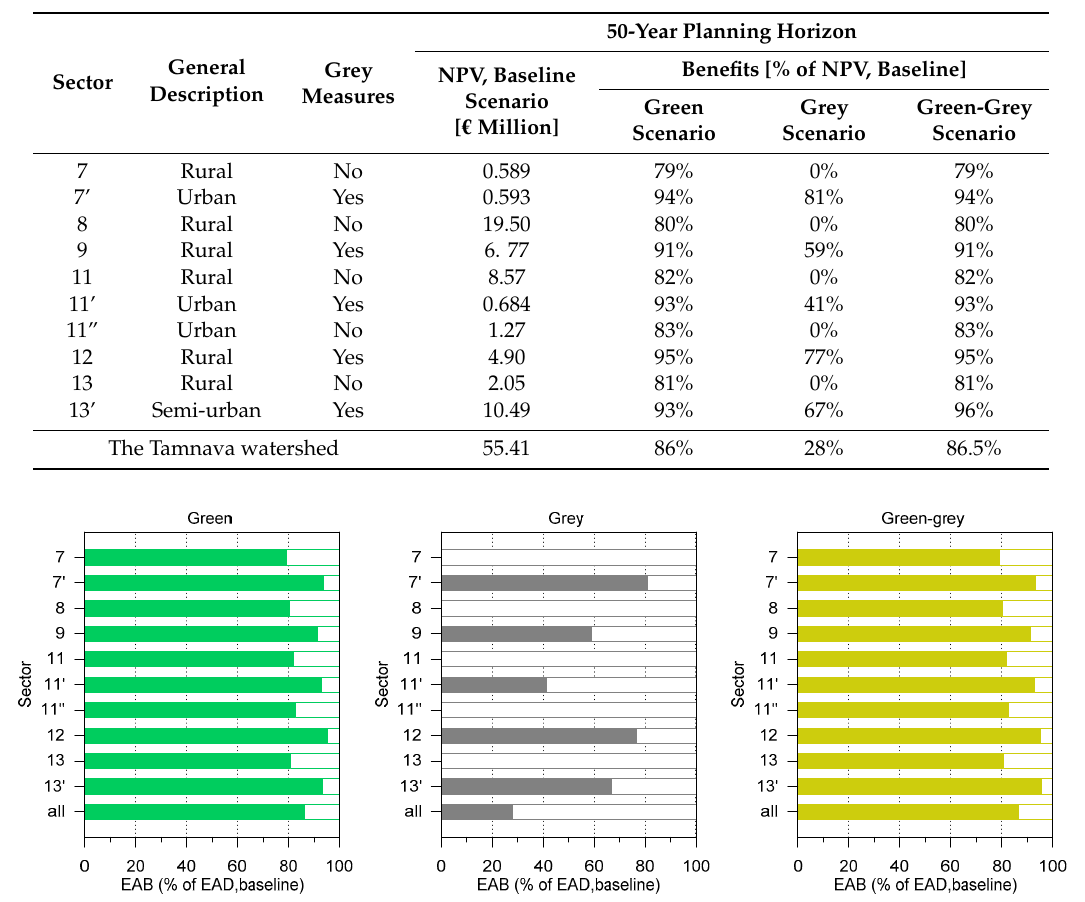
Table 8. Benefits due to implementing flood protection measures under different scenarios, relative to the baseline one (existing flood protection measures) over 50-year planning horizon in each river section and in the entire watershed.